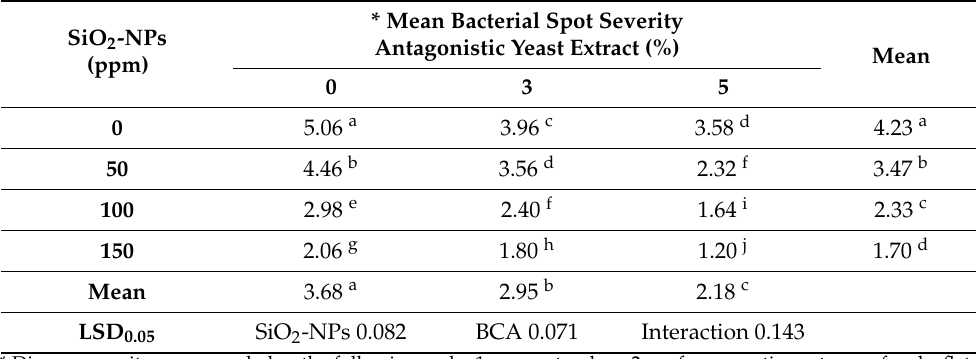
Table 2. Bacterial spot disease incidence and severity on sweet pepper leaves after infection, as affected by different treatments of SiO 2 -NPs (ppm), and BCA